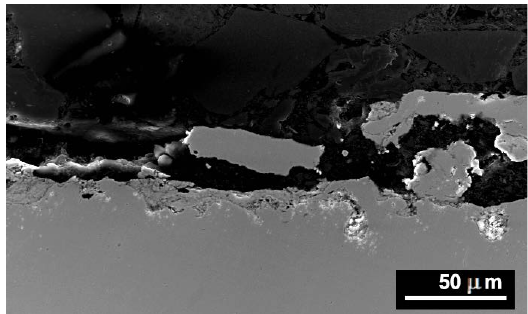
Figure 11. Cross section after the ball-on-disk tests for coating 3 at 800 °C.